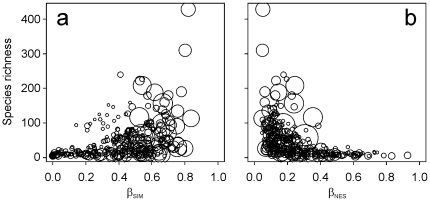
Relationship between (a) βSIM and regional species richness and (b) between βNES and regional species richness.Dot size is proportional to the altitudinal range of considered cells.